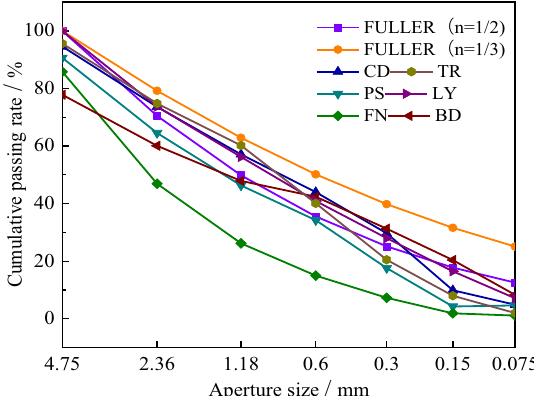
Fig. 2 Particle size distribution of fine aggregates